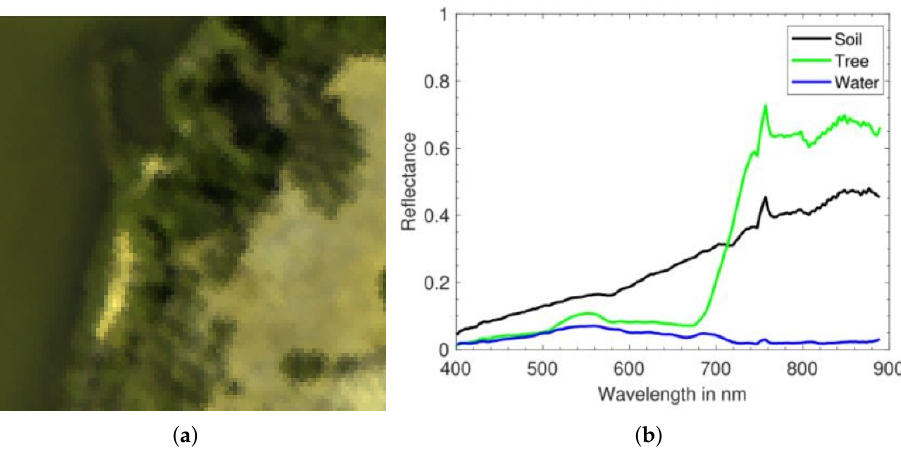
Figure 4. Samson image: ( a ) Samson color image ((Red: 571.01 nm, Green: 539.53 nm, and Blue: 432.48 nm) ( b ) Ground truth endmembers.